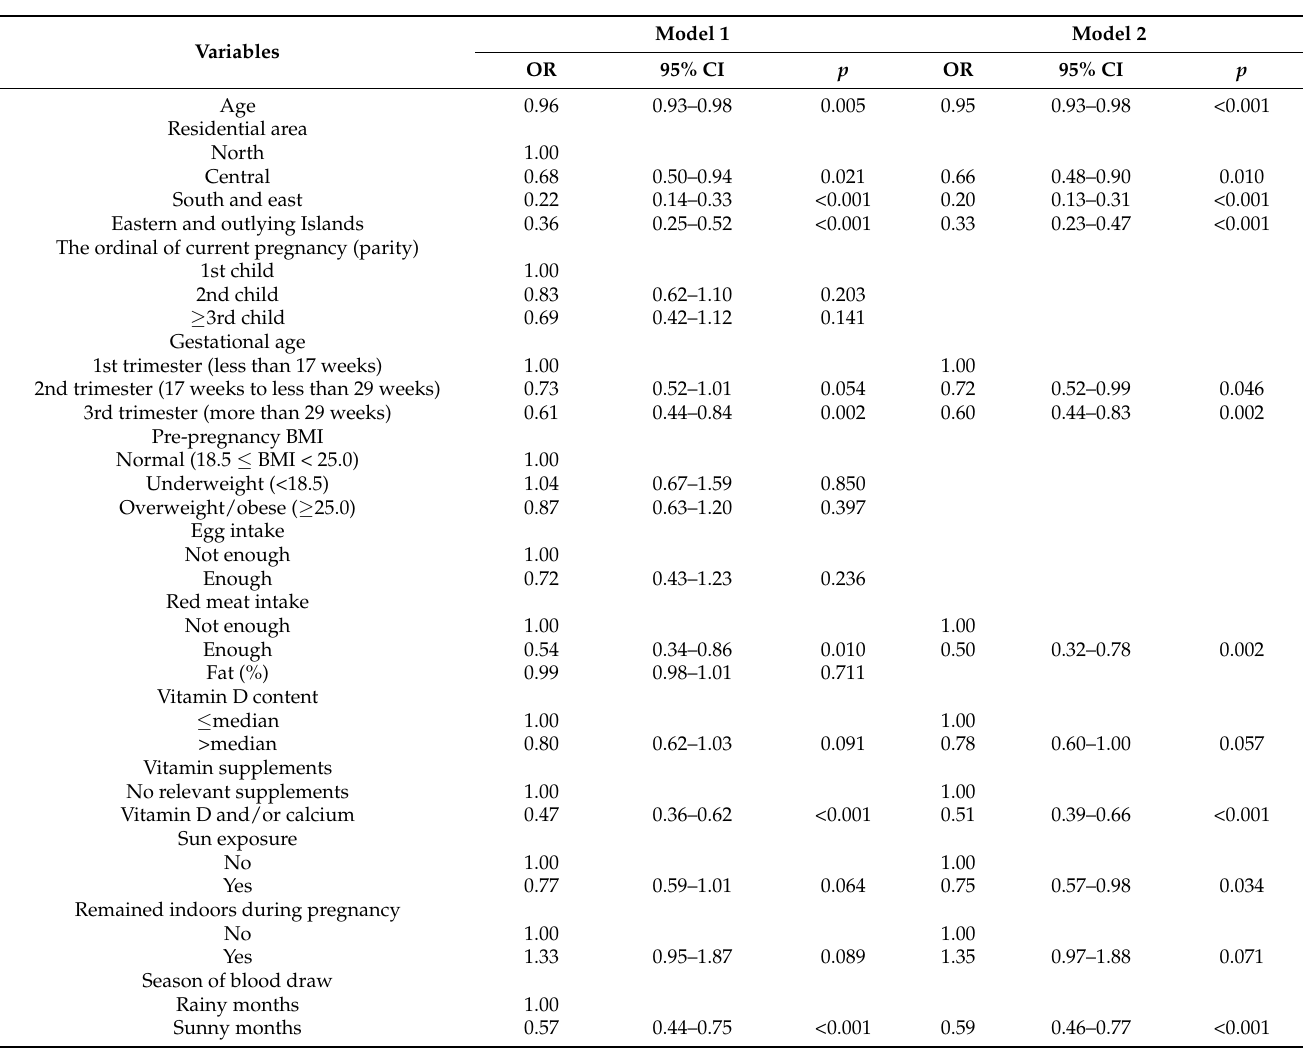
Table 2. Factors associated with vitamin D deficiency via multiple logistic regression analysis models ( n = 1502).